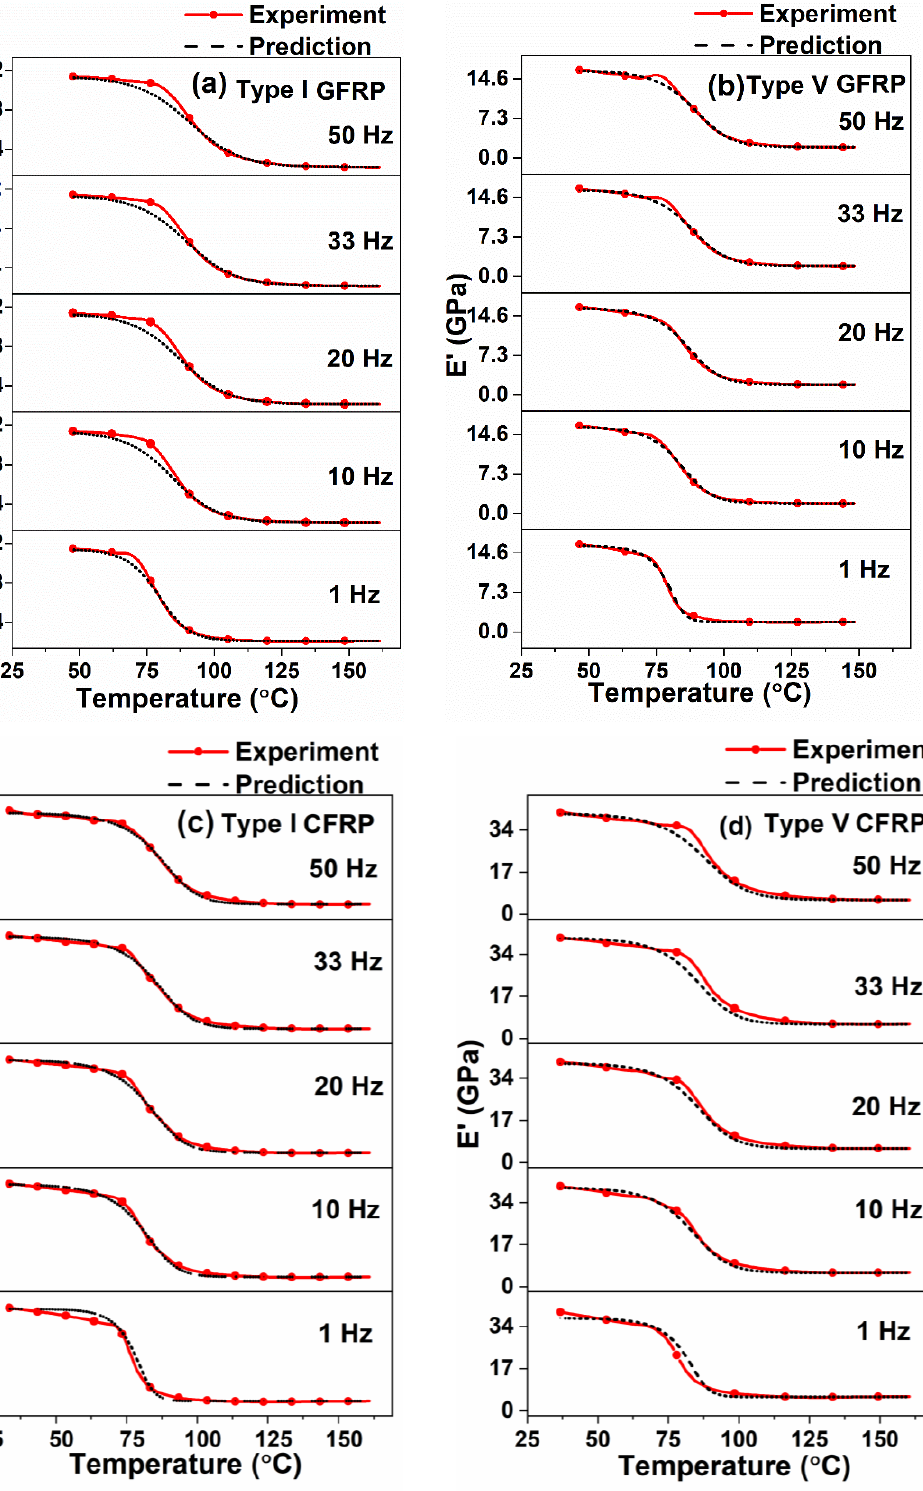
Figure 8. Comparison of predicted storage modulus values with the experimental values for different frequencies: ( a ) Type I GFRP, ( b ) Type V GFRP, ( c ) Type I CFRP and ( d ) Type V CFRP.